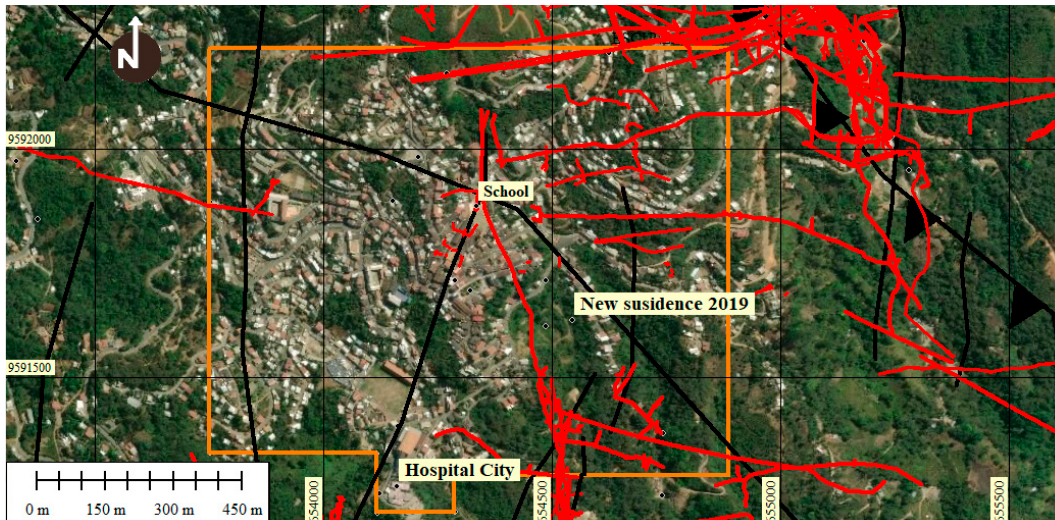
Figure 5. Underground locations of mining galleries outside and within the exclusion area of the Zaruma city. In ocher color, the Exclusion Zone polygon, the mining galleries from the center to the east in red lines, the mineralized structures and geological faults in black color lines. Dots black color are bocamines. Data source: Risk Management Secretariat.